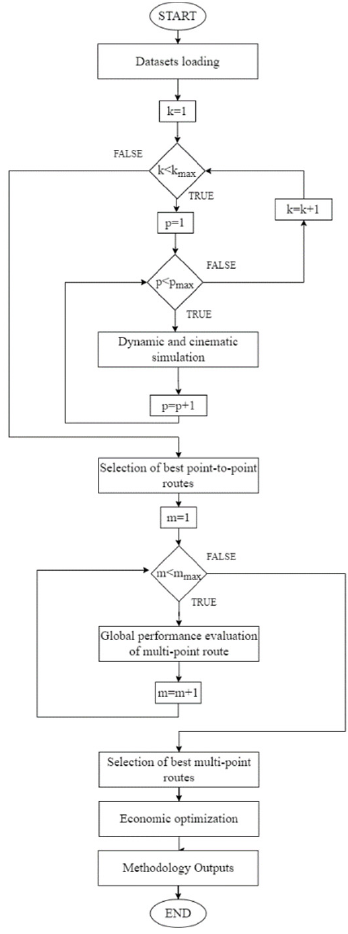
Figure 3. Flowchart of the tool for e-mobility service feasibility study, implemented in MATLAB environment.